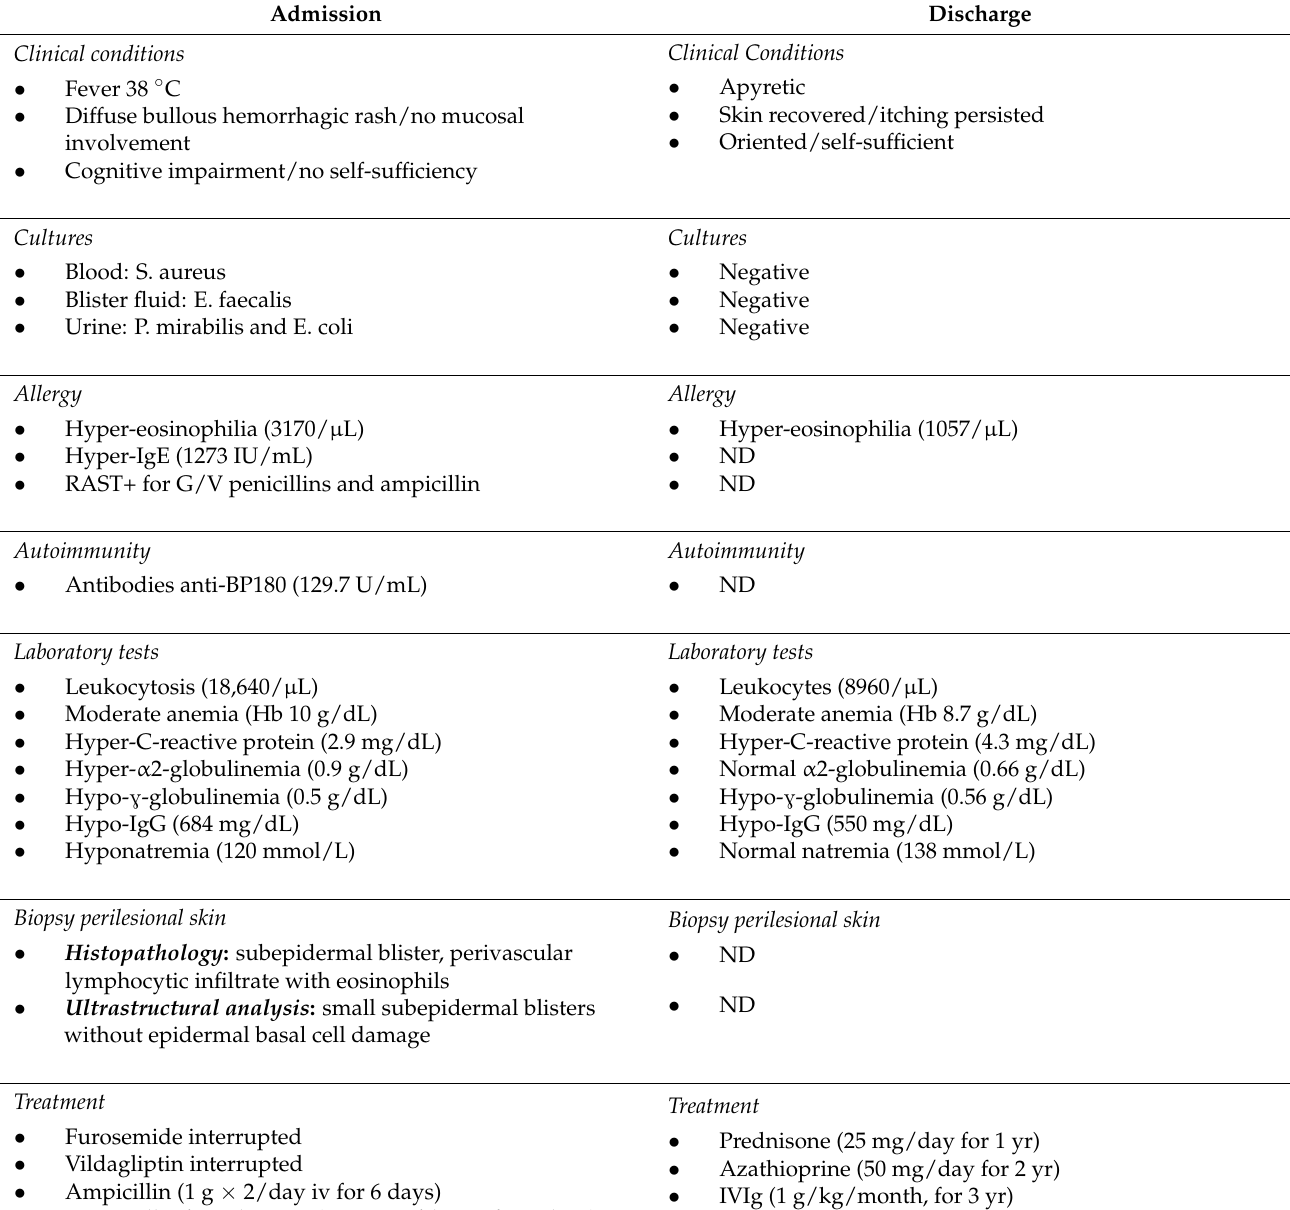
Table 1. Clinical and laboratory patient characteristics at admission to and discharge from the